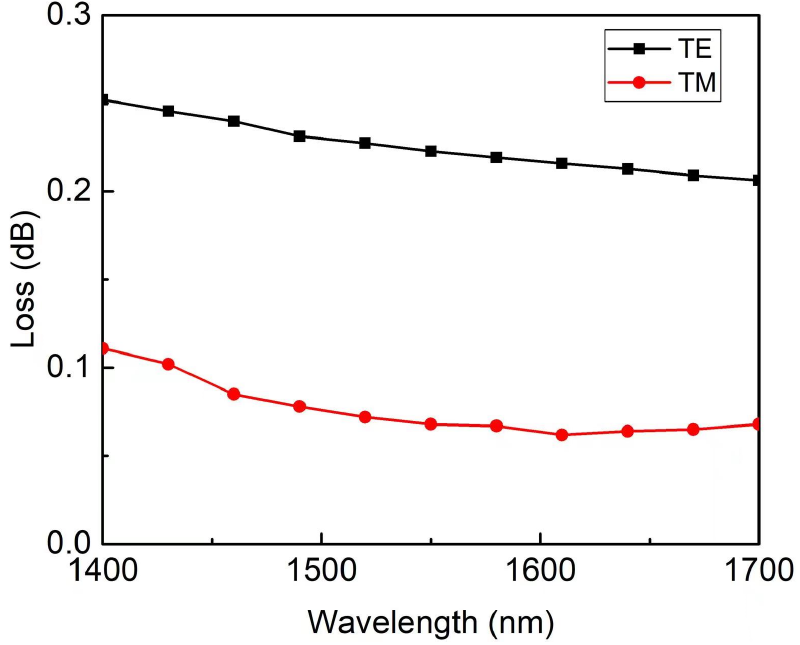
Figure 5. Wavelength dependence of coupling loss between the SiN waveguide and the SMF-28 fiber.